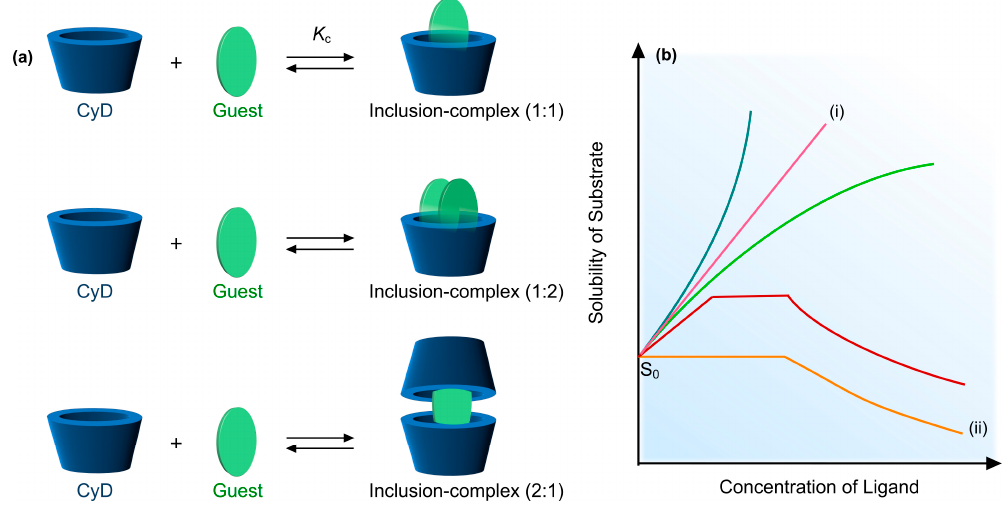
Figure 3. ( a ) The inclusion complex formation between CyD and guest molecules at various stoichiometries. ( b ) The plot shows a phase solubility of guest molecules; (i) represents the formation of soluble inclusion-complex (IC), and (ii) denotes the formation of IC with limited